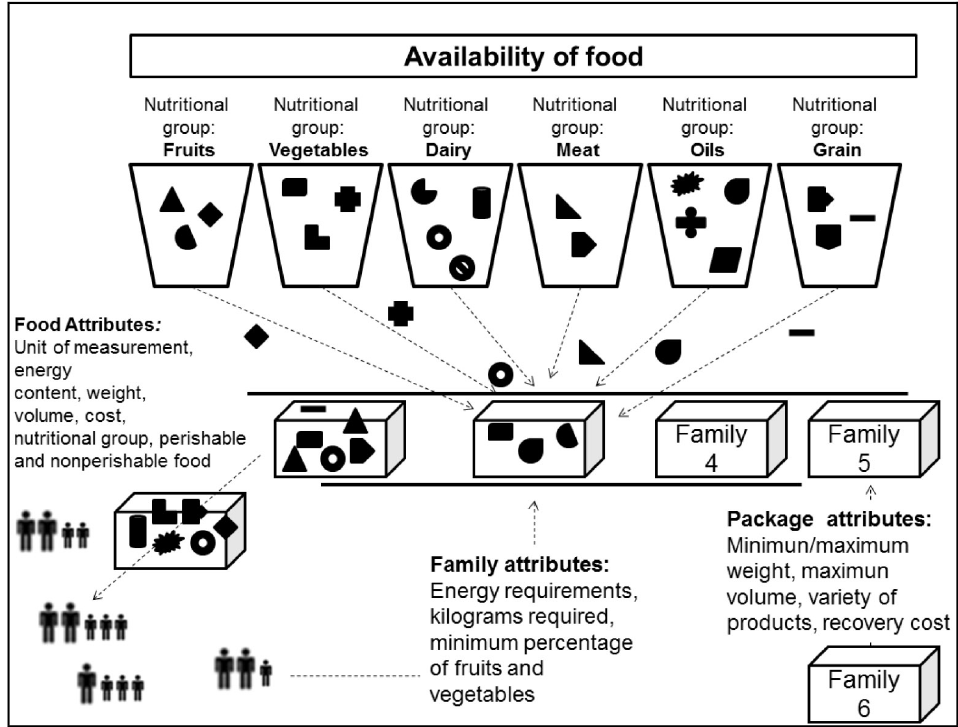
Figure 1. Food allocation-packing system to customize food pantries (Cuevas-Ortuño & Gomez-Padilla,